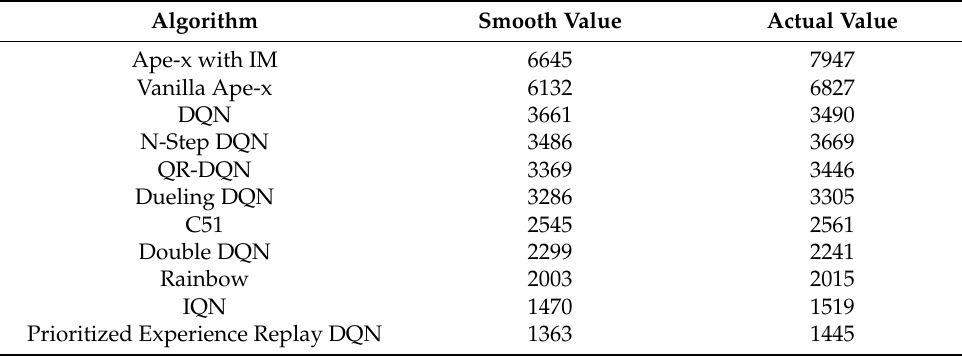
Table 8. Ordinate comparison of the algorithms at 1.6 M gradient